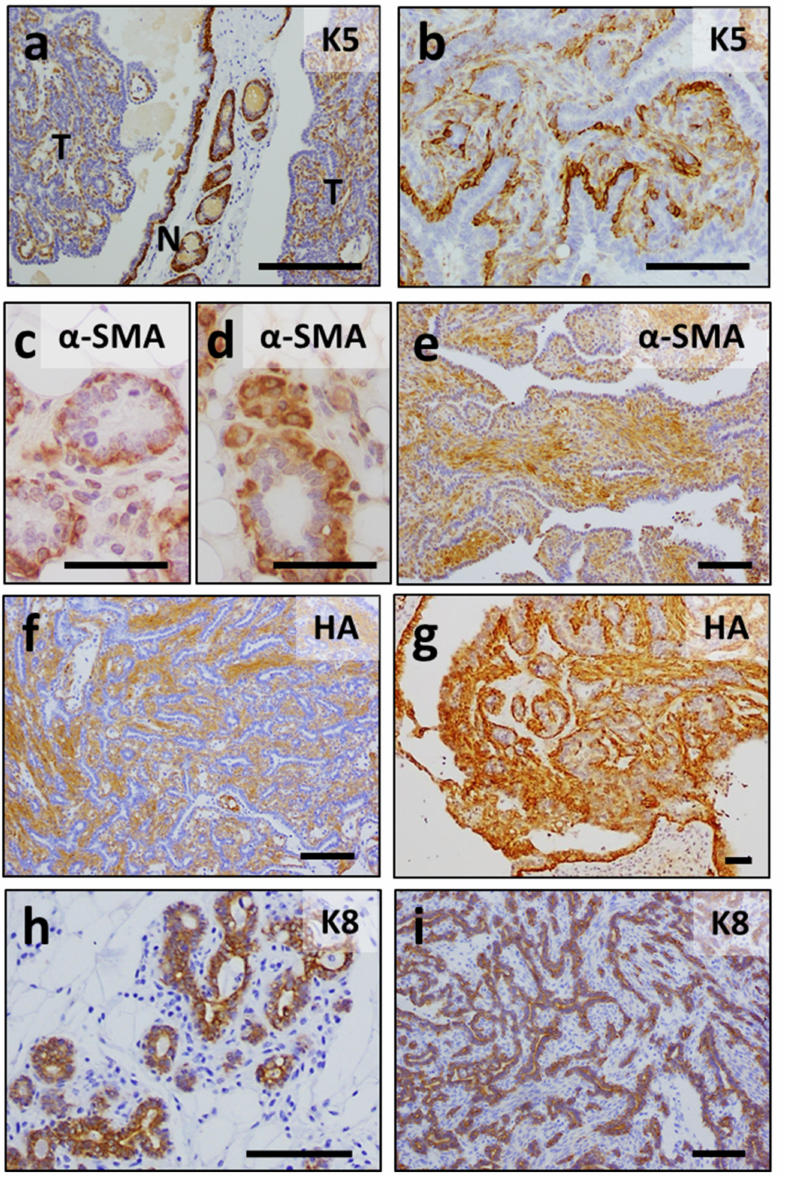
Figure 8. Immunohistochemical analyses of K5-ERAS mammary gland tumors. ( a – i ) Immunohisto- chemical staining of non-tumoral mammary gland (( c , d , h ), and region marked N in ( a )), tumoral samples (( b , e – g , i ) and regions marked T in ( a )) of K5-ERAS transgenic ( a , b , d – g , i ) and non-tumoral sample of 7-month-old WT mice ( c , h ) using antibodies specific for the indicated epitopes. Note the expression of K5 ( a , b ) and α -SMA ( e ) in K5-ERAS tumors, confirming their myoepithelial origin, as well as the co-localized expression of ERAS (HA epitope) ( f , g ), while acinar cells expressed K8 ( i ). Bar: 100 µ m except for ( c , d ) (50 µ